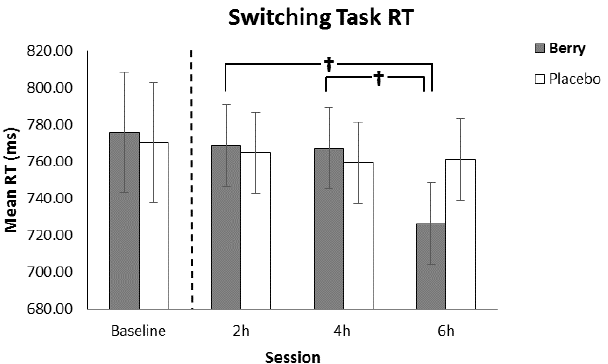
Figure 6. Reaction time (±SE of the mean) as a function of intervention and session, showing significantly faster performance at 6 h in comparison to 2 and 4 h for the berry intervention. Baseline performance, included as a covariate in the analysis, is shown separated by the dotted line. † p < 0.001.